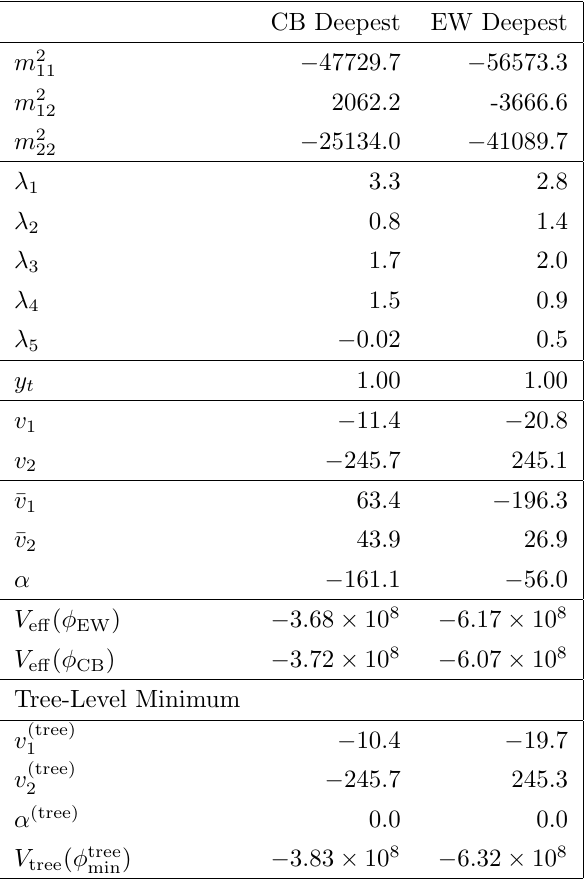
Table 2. Parameter values. Quadratic parameters in GeV 2 , VEVs in GeV and potential values in GeV 4 . All values have been rounded for